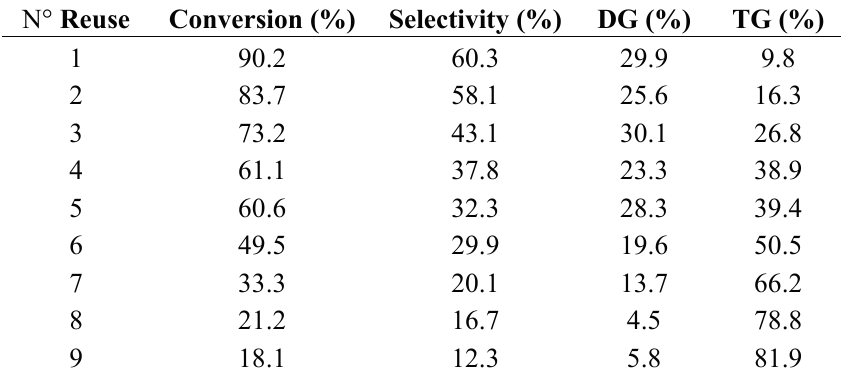
Table 6. Conversion and selectivity values (in %) obtained in the successive reuse of Biolipase R immobilized by physical adsorption on demineralized sepiolite at pH 9, operating under standard conditions: (30 °C, with 12 mL of sunflower oil, 3.5 mL of absolute ethanol (1:6 oil/ethanol molar ratio) and pH 11, with 1.6 g of supported biocatalyst (15 wt % with respect to the oil used).